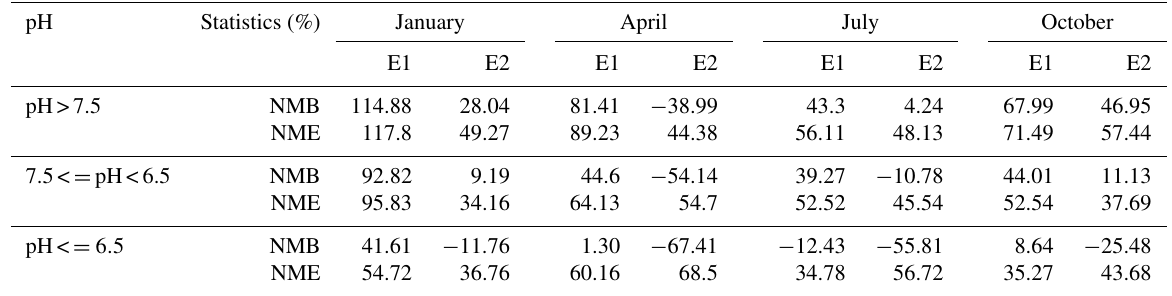
Table 5. The NMBs and NMEs between the simulated and observed daily NH 3 VCDs by soil pH and month. pH Statistics (%)